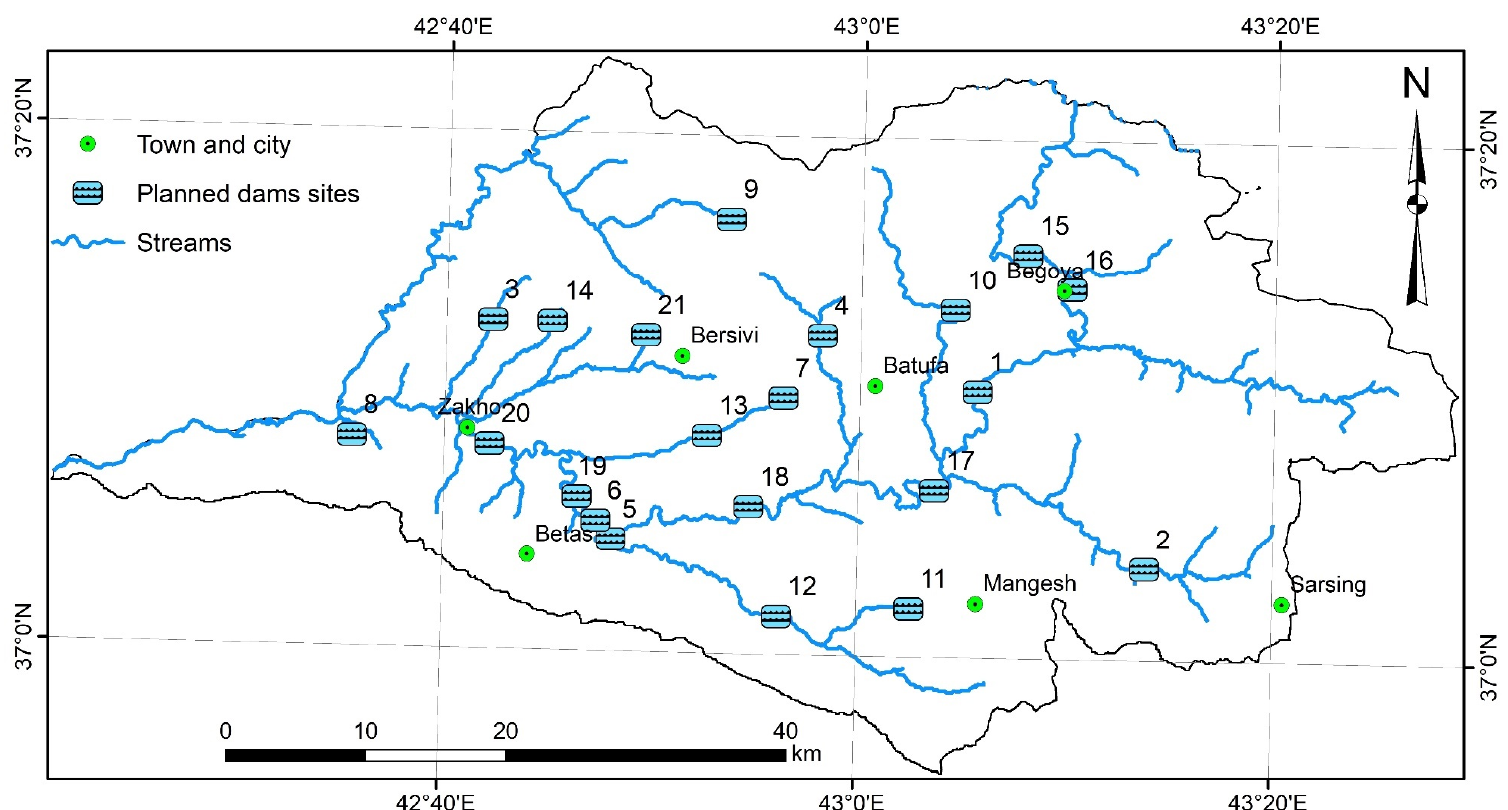
Figure A1. Planned dam sites by the Ministry of Agricultural and Water Resources, Kurdistan Region, Iraq [16].